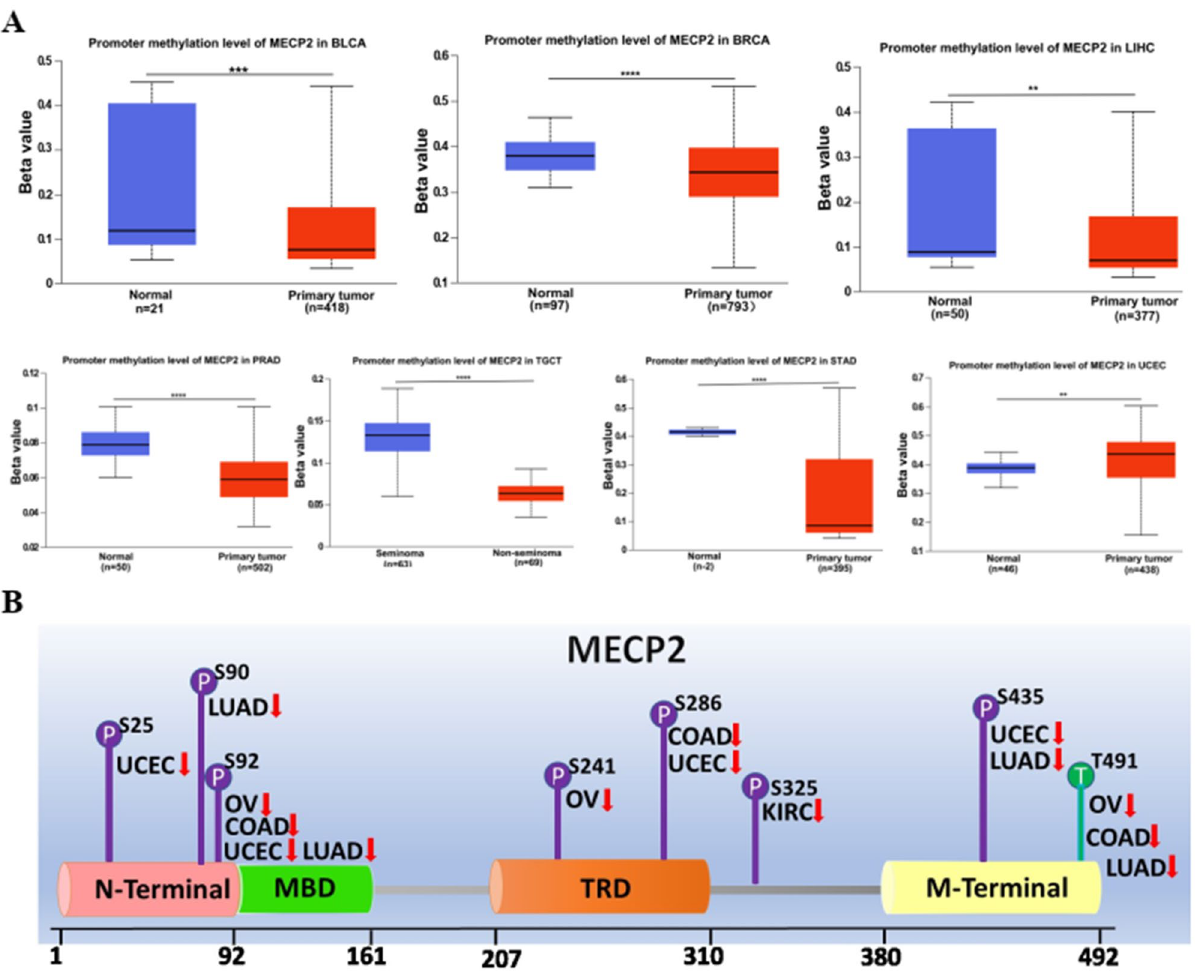
Figure 5. DNA methylation and Phosphorylation analysis of MeCP2protein in several tumors via UALCAN database. (A) DNA Promoter methylation level of MeCP2 in BLAC, BRCA, LIHC, PRAD, TGCT and UCEC. (B) The schematic diagram of MeCP2 protein phosphoprotein sites. (C) The phosphorylation of MeCP2 protein was analyzed in BRCA, OV, KIRC, COAD, UCEC, and LUAD. * P < 0.05, ** P < 0.01, *** P < 0.001, **** P < 0.0001, ns:no